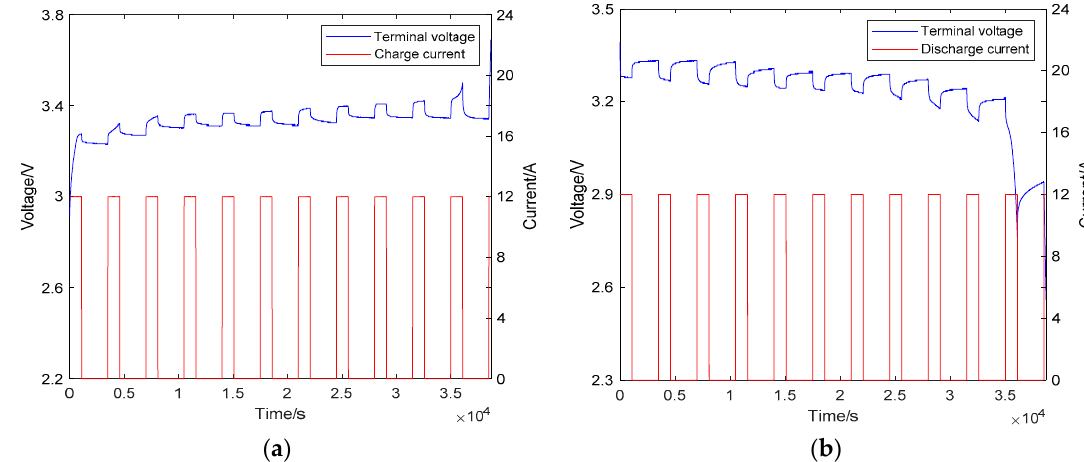
Figure 5. Voltage and current curves of the intermittent constant current charging and discharging experiments: ( a ) Charging process; ( b ) Discharging process. Table 2. The state of charge (SOC)-open circuit voltage (OCV)